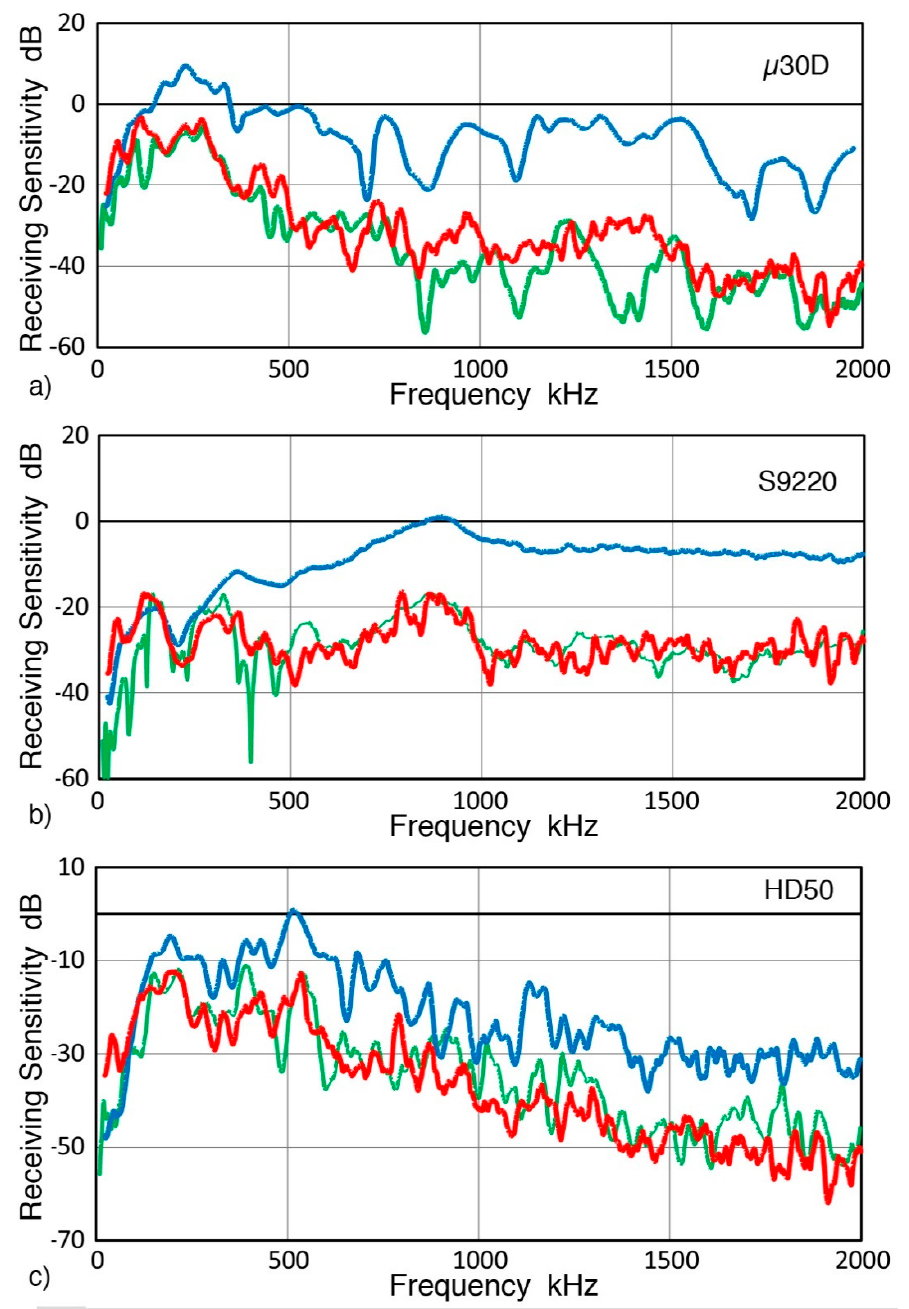
Figure A2. Receiving sensitivities of three AE sensors to three wave modes, NW (blue curves), RW (green curves), and GW (red curves). ( a ) µ30D sensor, ( b ) S9220 sensor, and ( c ) HD50 sensor.